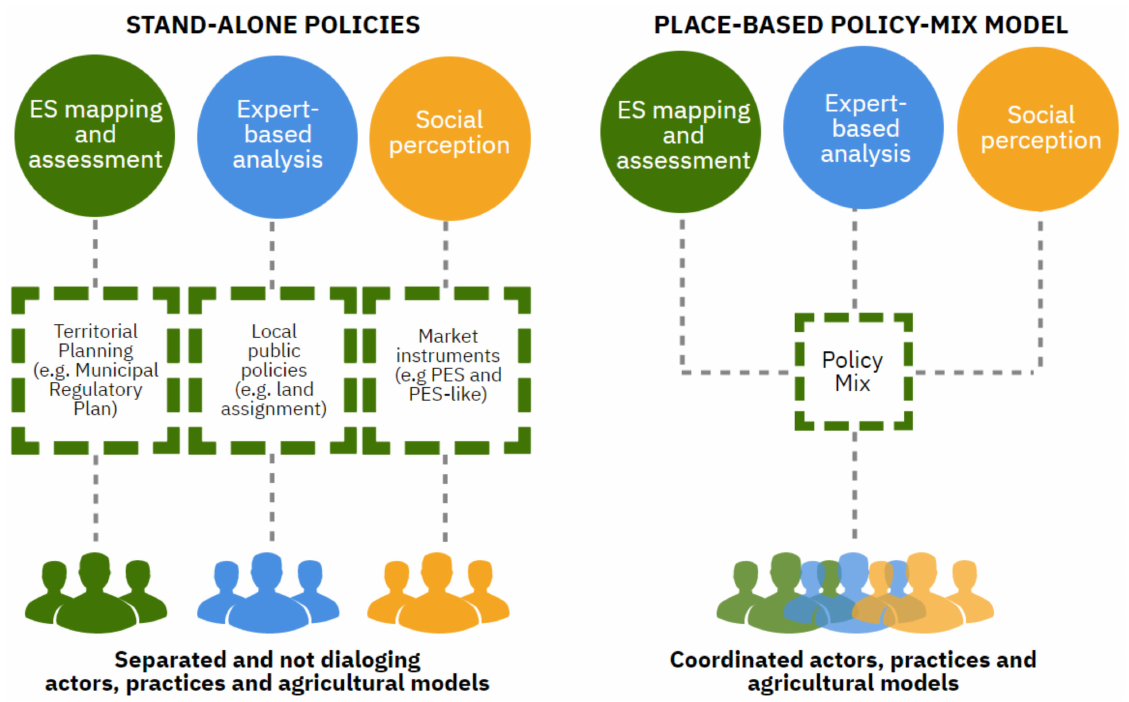
Figure 9. Comparison of the “stand-alone policies” scenario and the “place-based Policy-mix”